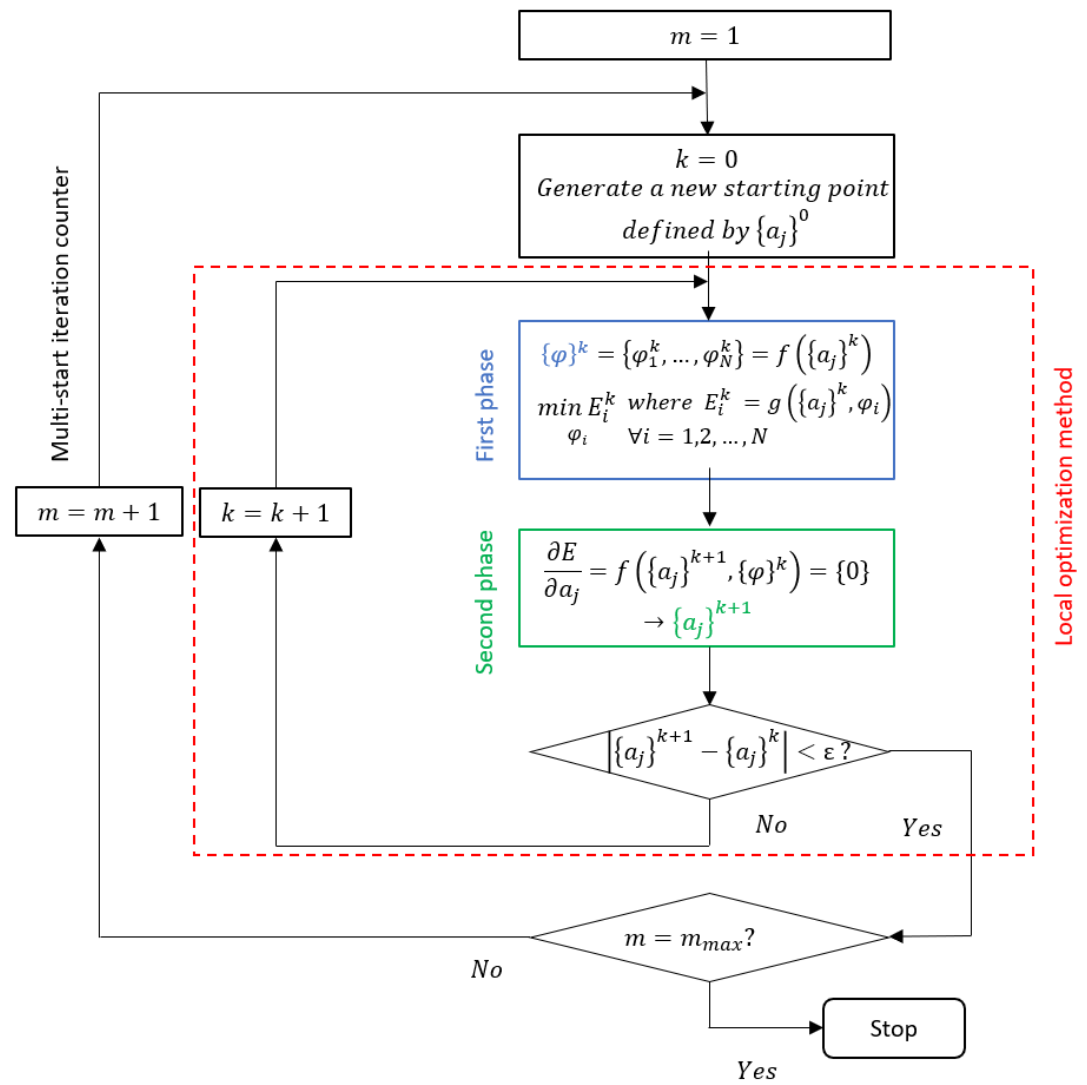
Figure 6. Flowchart of the hybrid optimization scheme.